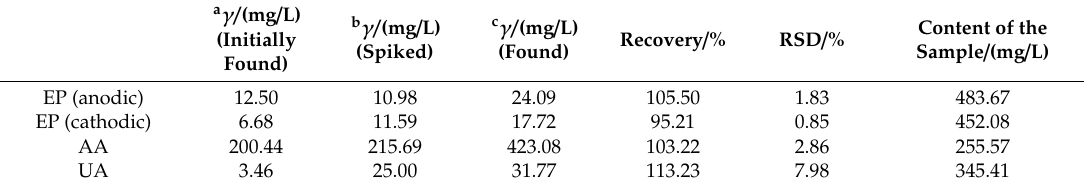
Table 6. Results of real sample analysis for all 4 methods using the weighted regression model presented in Tables 3 and